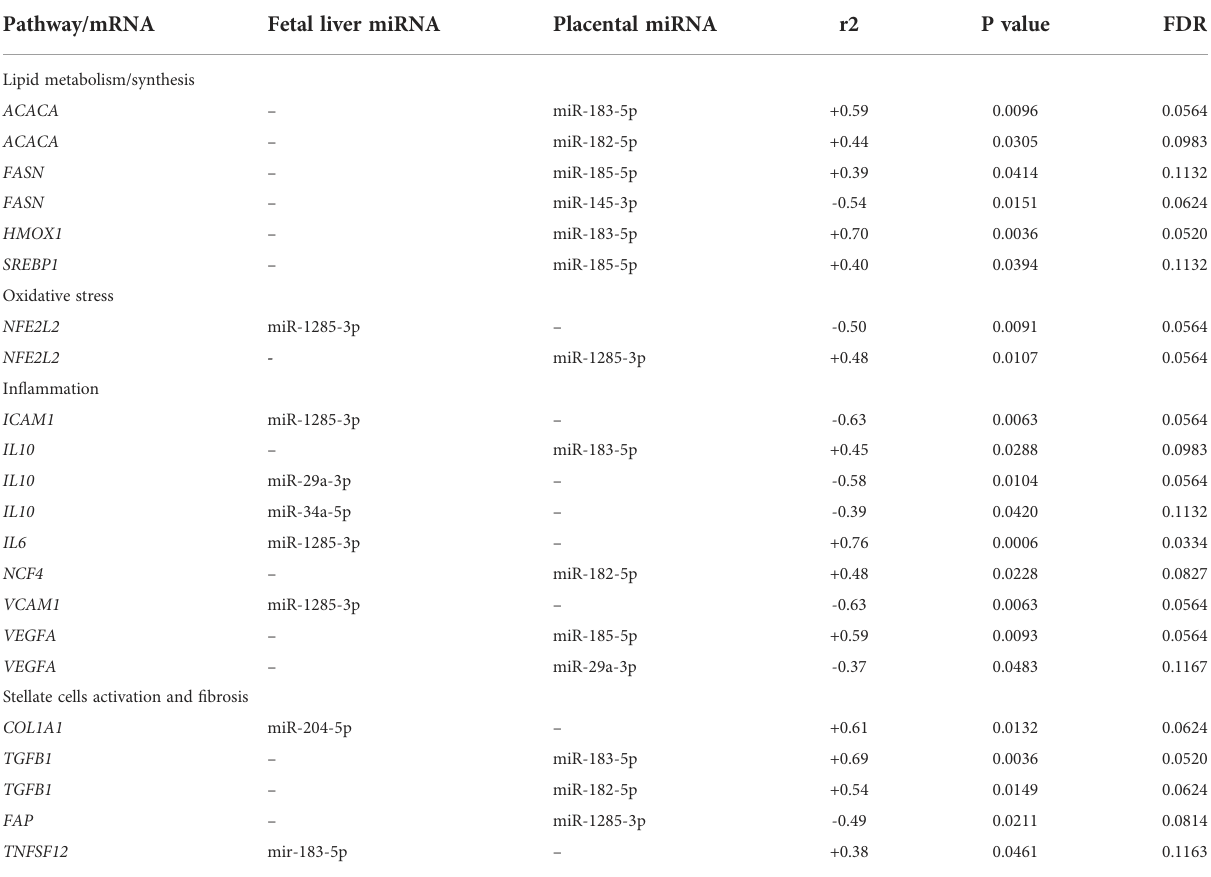
TABLE 4 Associations between miRNAs and fetal liver mRNA expression levels. Pathway/mRNA